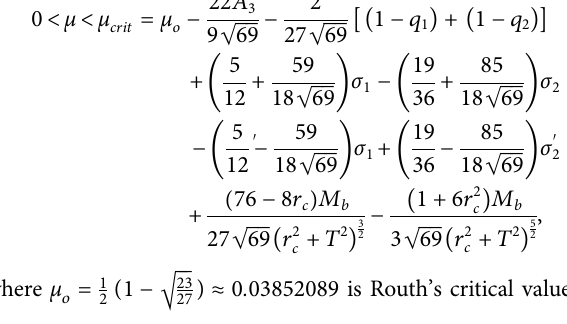
TABLE 7 | Positions ( x 0 , ± y 0 ) of the two triangular points L 4 and L 5 of the binary HD155876 system for three fi xed values of M b when A 3 varies. The radiation pressure and triaxiality parameters are kept as constants as in the collinear case (Table 6) . L M b = 0.06 4,5 :